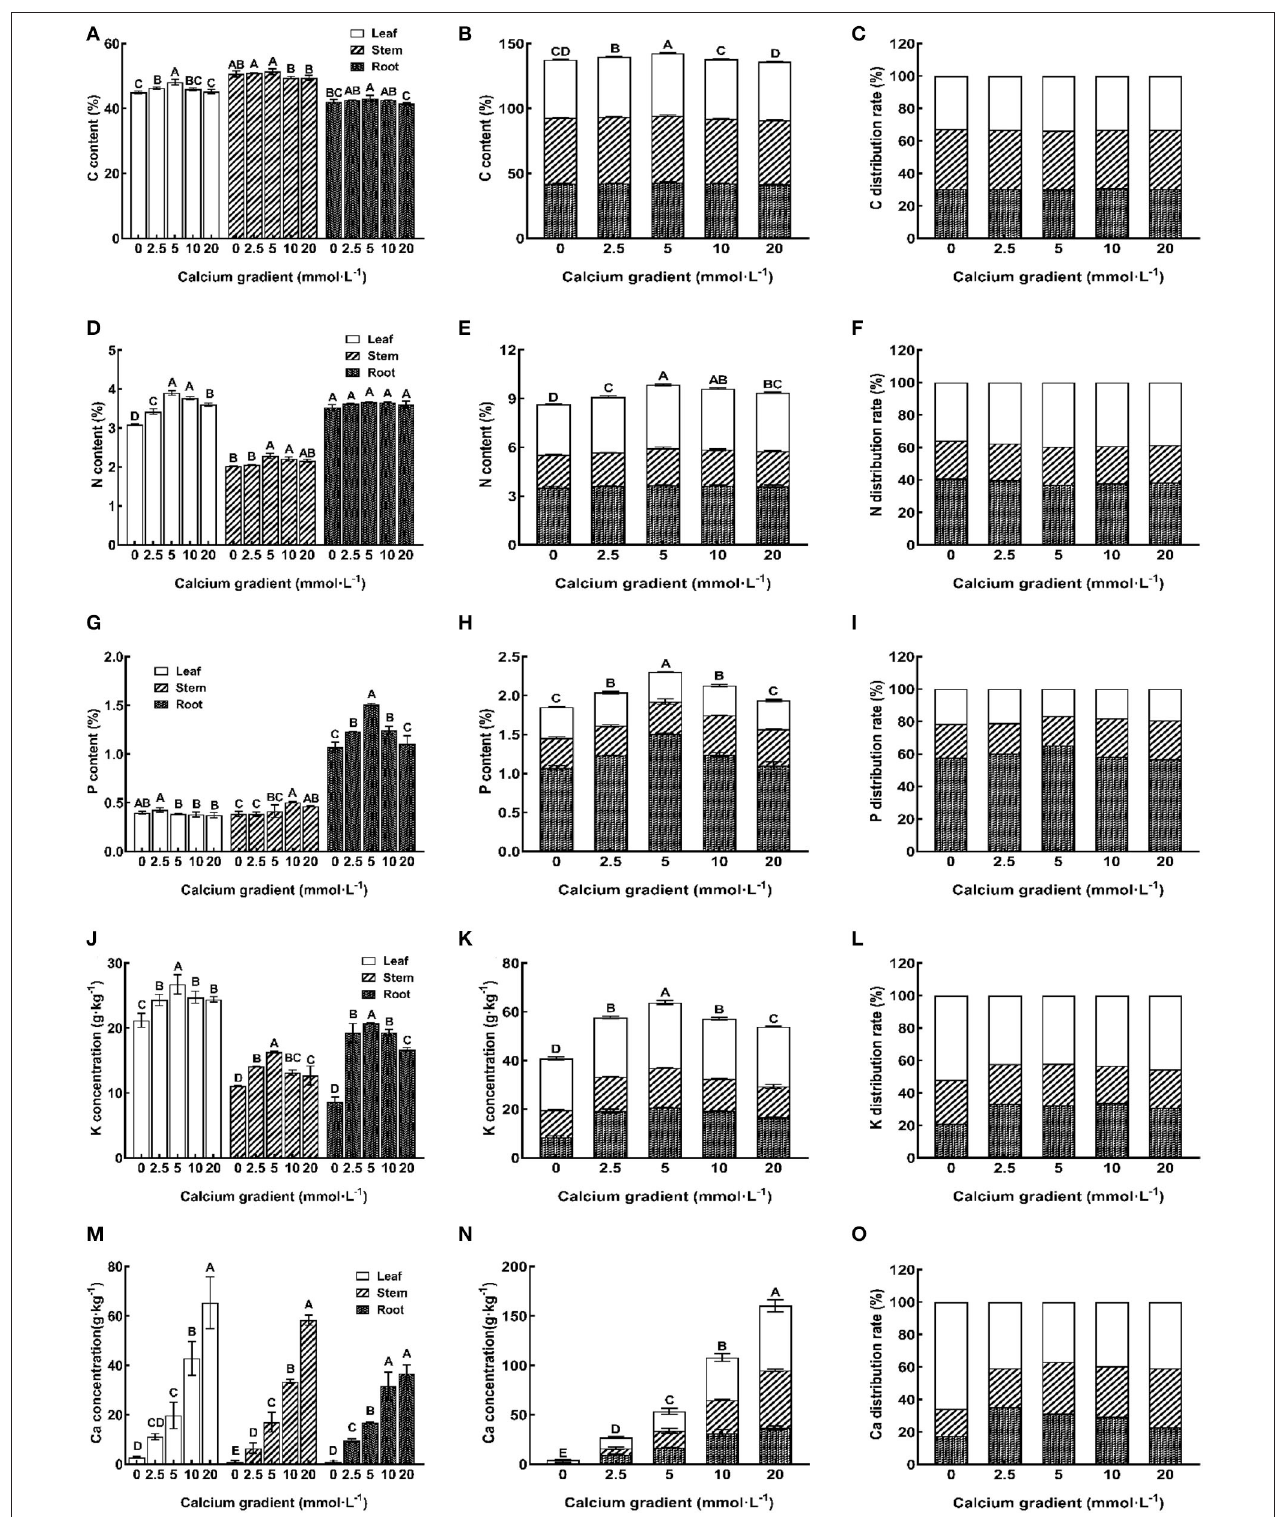
FIGURE 6 | Effect of calcium on nutrient element absorption and distribution of poplar seedlings. Each column shows the mean ± SE value, n = 3. Different capital letters indicated significant differences between treatments of calcium addition ( P < 0.05).